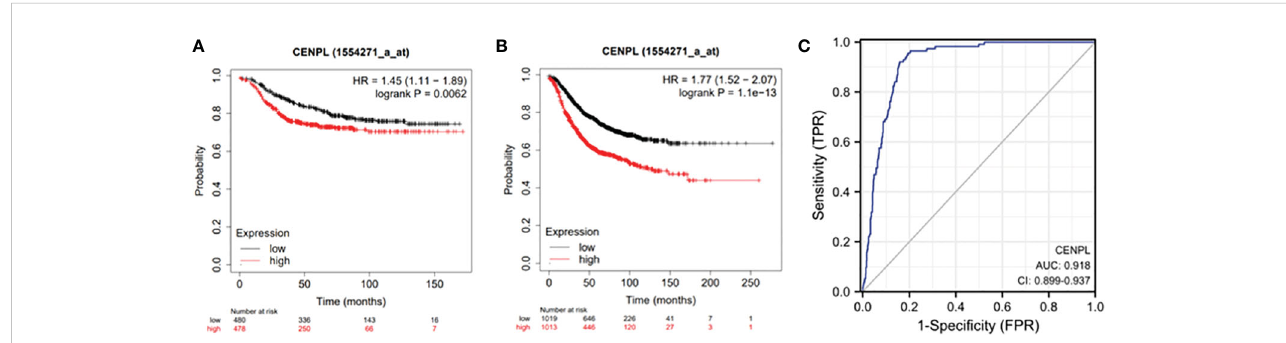
FIGURE 2 Expression of CENPL and prognosis of breast cancer patients. (A) RFS of breast cancer patients based on CENPL expression level and (B) DMFS of breast cancer patients based on CENPL expression level.